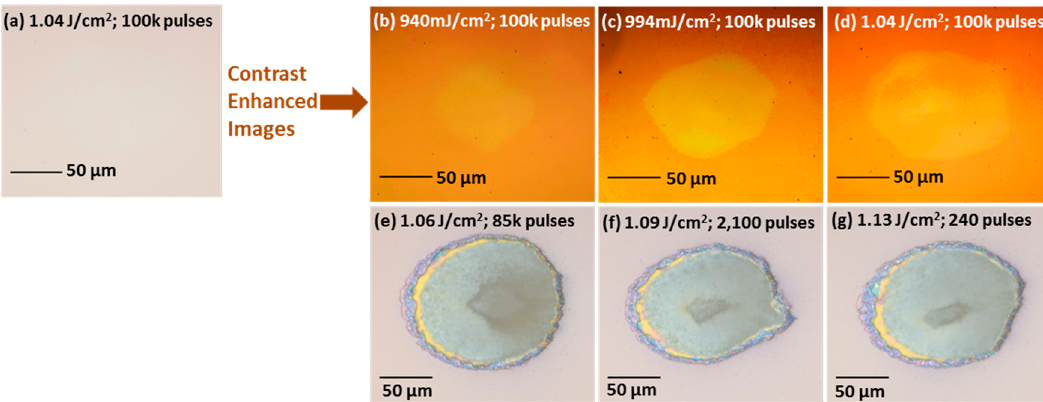
Figure 4. The laser-induced damage growth on the surface of the MLD coating is shown for laser fluence increasing from ( b – g ). The image ( a ) is a Nomarski microscope image and corresponding enhanced contrast image is shown in ( d ). The image ( d ) is highlighting the invisible features in ( a ) at 1.04 J / cm 2 . The similar enhanced contrast bright field images are shown in images ( b , c ).